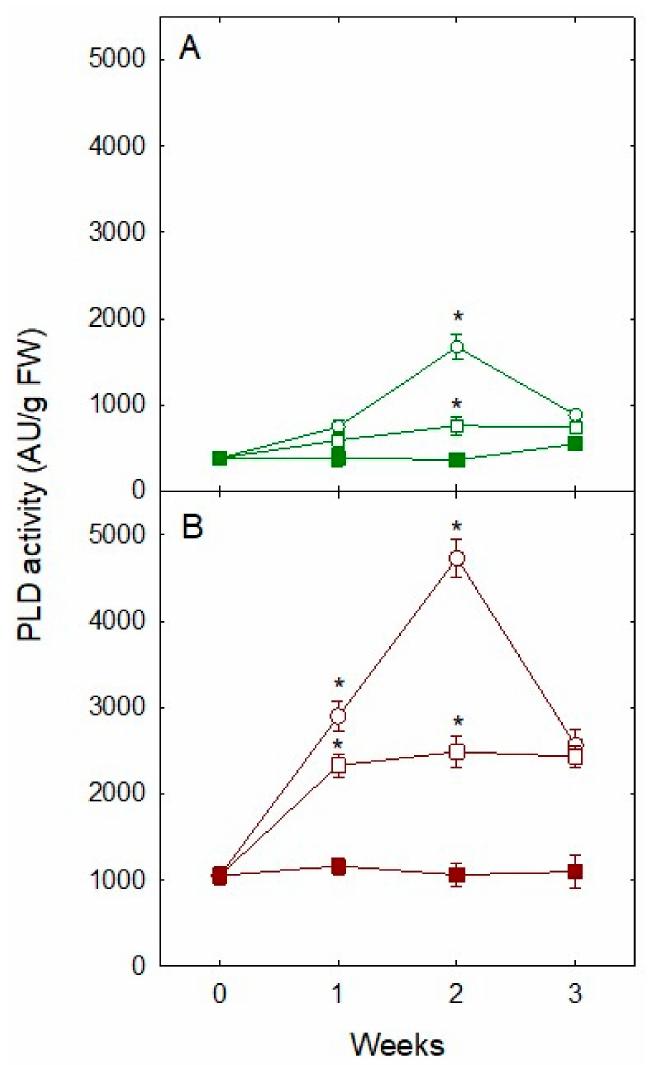
Figure 2. Phospholipase D (PLD) activity in response to di ff erent conditions of water stress (severe drought (0% ET, O), mild drought (%50 ET, (cid:3) ), and fully watered plants (100% ET, (cid:4) )) in ( A ) leaves and ( B ) roots of ‘Pineapple’ sweet orange trees during a 3-week period. Data are means ± SE of three biological replicates. Asterisks indicate significant di ff erences at * p <